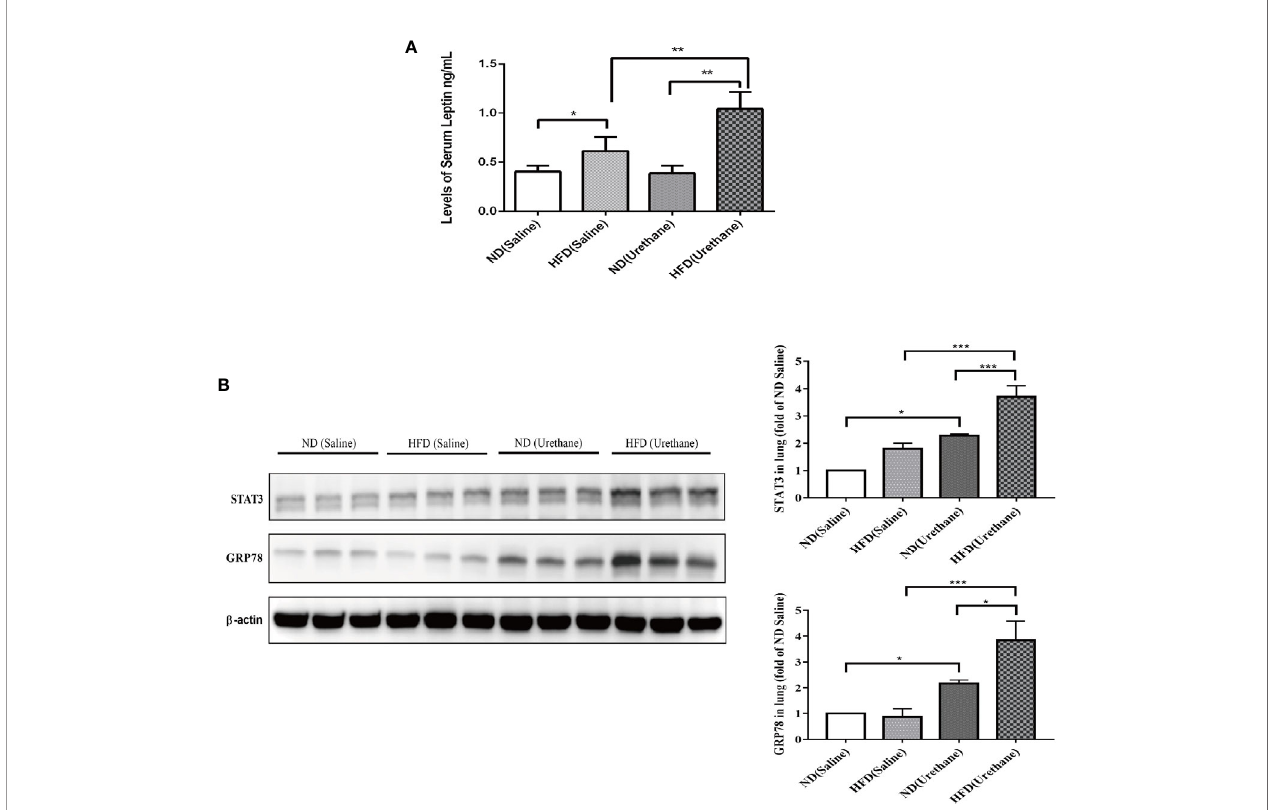
FIGURE 4 | The expression of leptin in serum and target protein expression in lung tissues of C57BL/6J mice. (A) Serum leptin levels in different groups of C57BL/ 6J mice as measured by ELISA (n =3 – 5 mice/group). *P < 0.05, **P < 0.01. (B) Pulmonary expression of STAT3 and GRP78 in different groups of C57BL/6J mice shown by western blotting (n=3 mice/group). *P < 0.05, **P < 0.01, ***P <